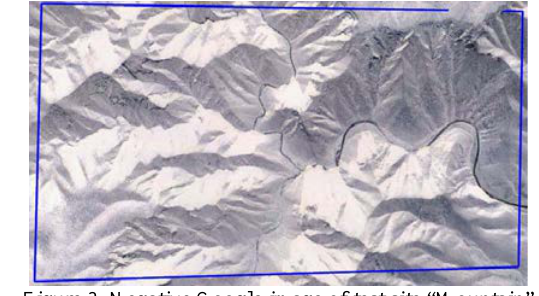
Figure 3. Negative Google image of test site “Mountain” Center: W104.78° N31.98°, 5.2km x 2.8km